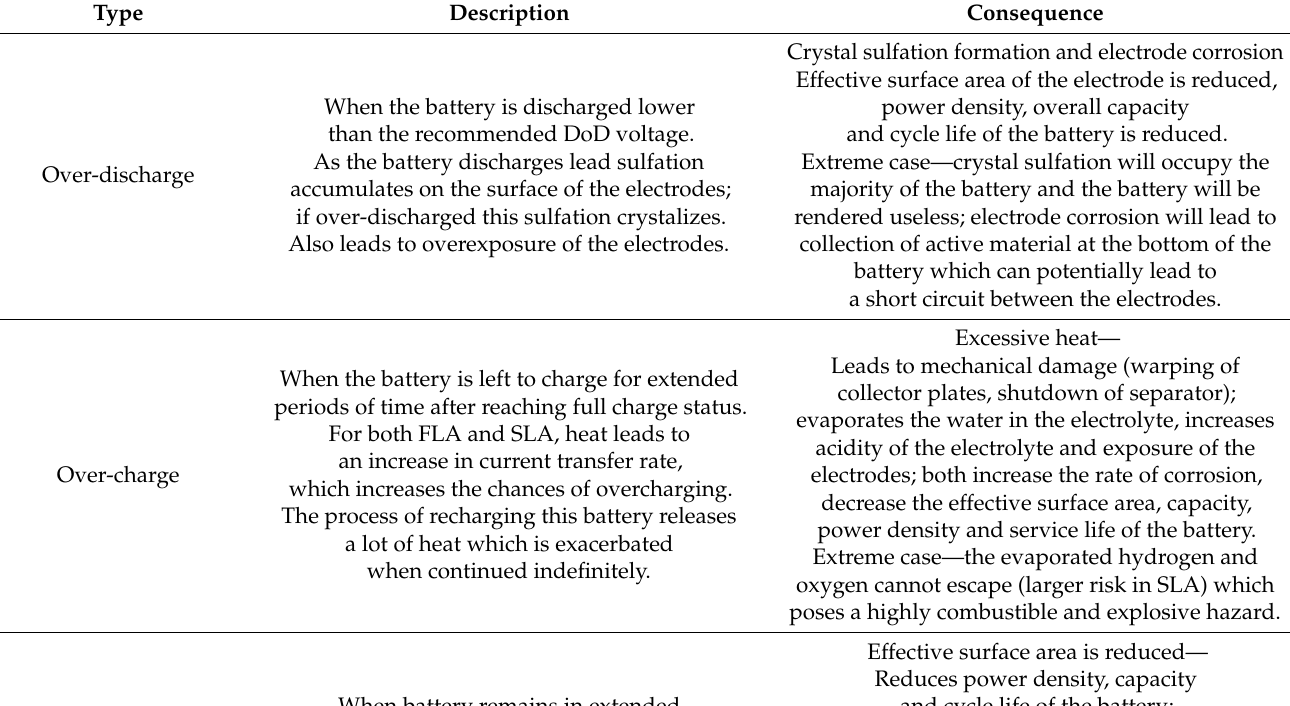
Table 6. Causes of degradation in lead acid batteries, adapted from